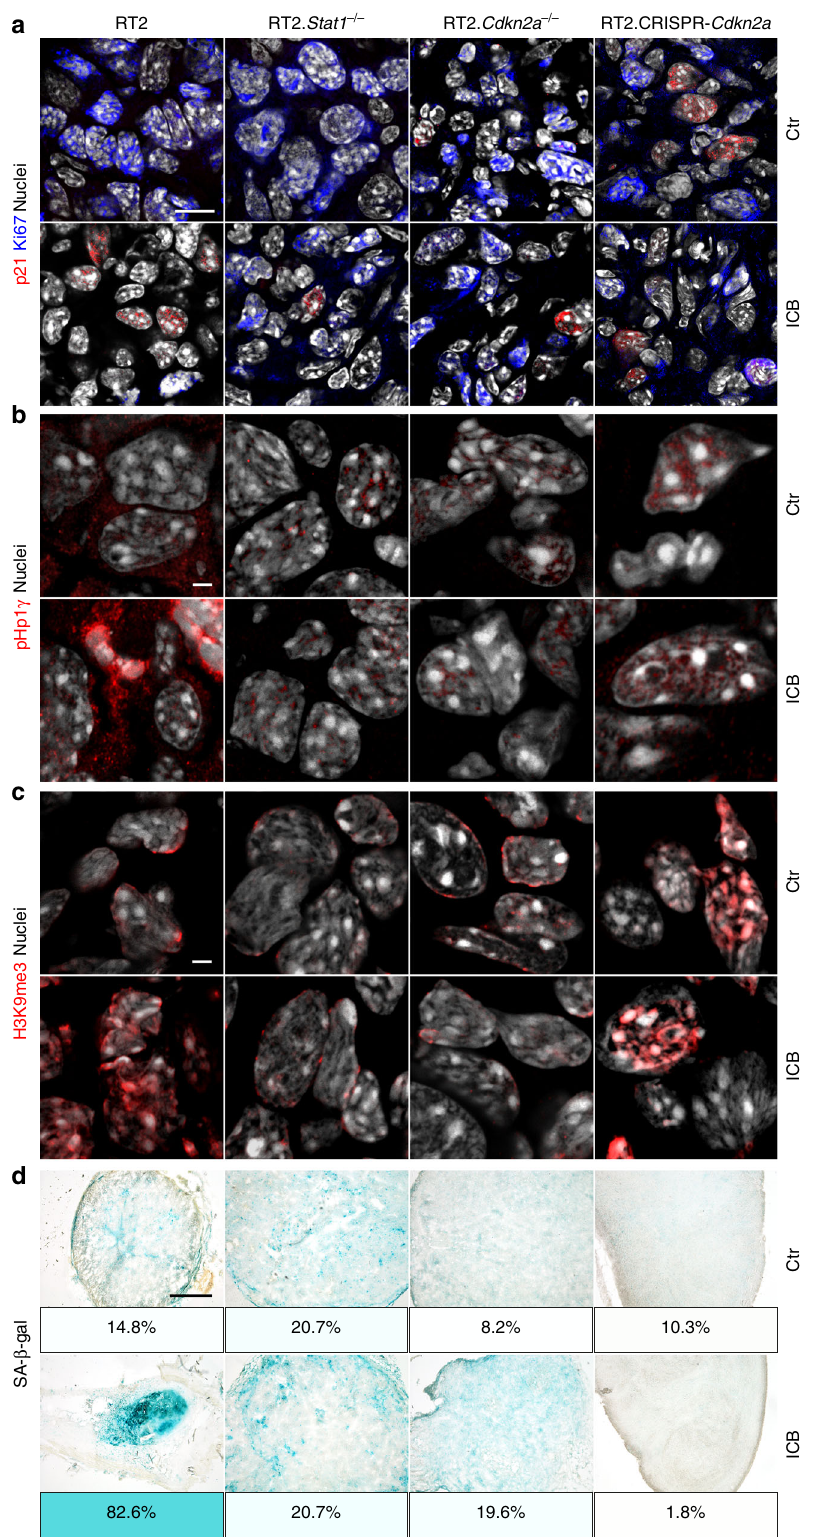
Fig. 2 Stat1 - and Cdkn2a -dependent induction of the senescence markers pHP1 γ , H3K9me3, and of SA- β -gal in transplanted RT2-cancers. a – d Representative microscopic images of s.c. RT2-cancers from either RT2-, RT2. Stat1 − / − -, RT2. Cdkn2a − / − - or from RT2.CRISPR- Cdkn2a -cancer cells. Mice were treated with isotype control mAbs (Ctr) or with immune checkpoint blockade (ICB, anti-PD-L1 and anti-LAG-3). Staining for the senescence marker p21 Cip1 (red), the proliferation marker Ki67 (blue) and for nuclei (white) ( a ), pHP1 γ (red), nuclei (white) ( b ), H3K9me3 (red), nuclei (white) ( c ). SA- β -gal activity at pH5.5 and percentage of SA- β -gal positive tumour cells in each tumour ( d ). The colour evaluation and calculation of the SA- β -gal + cells are described in Supplementary Fig. 2 and Methods (for d ). Scale bars 10 µ m ( a ), 2 µ m ( b , c ), 1000 µ m ( d ). Histology was performed in one to three representative tumours from Fig.